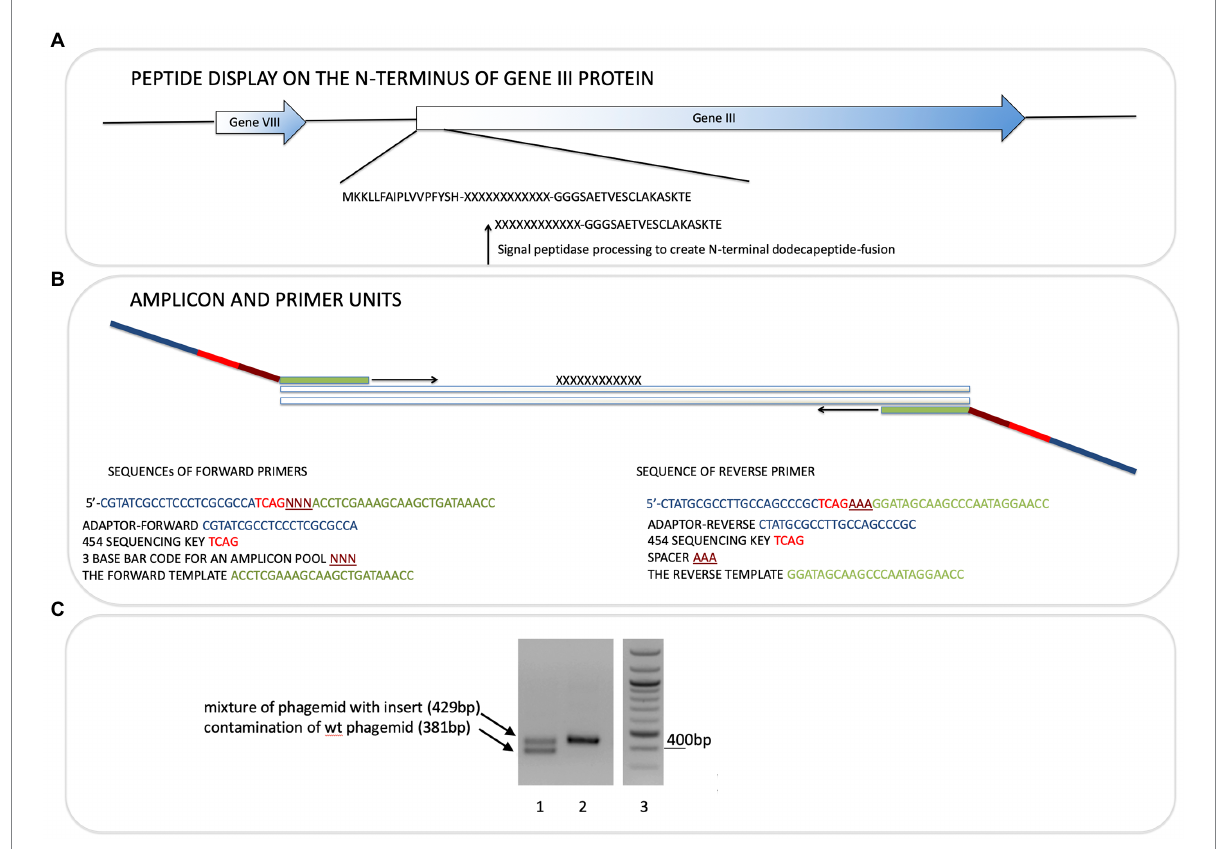
FIGURE 1 Next-generation sequencing of peptide-phage pools. His-tagged Ubiquitin or NEDD8 proteins were captured onto a nickel coated solid phase. After selection and elution of peptide phage, the phage DNA was amplified using PCR primer sets that capture the sequences flanking the peptide insert. (A) . The peptide sequence is at the N-terminus of the gIII M13 coat protein so that the dodecapeptide (X 12 ) would have a free N-terminus after signal peptide cleavage and the C-terminus of the peptide is linked to a GGG linker fused to gIII protein (Gene III). (B) . The primers used and bar codes for each PCR amplicon are highlighted, and include phages that were amplified or not amplified prior to DNA isolation for sequencing (Table 1). Pooling of all phage into deep sequencing reactions can be done with subsequent deconvolution using the trinucleotide “bar code” (NNN) whose position in the primer is indicated (Supplementary Table 2A; Figure 4 show examples of bar code stratification of peptide counts). (C) . An example of the amplification of peptide-phage library pools with primer pairs. The figure highlights a phage pool with a mixture of WT and peptide-containing phage (lane 1), relative to a representative peptide pool containing only peptide insert phage (lane 2) and DNA molecular mass markers (lane